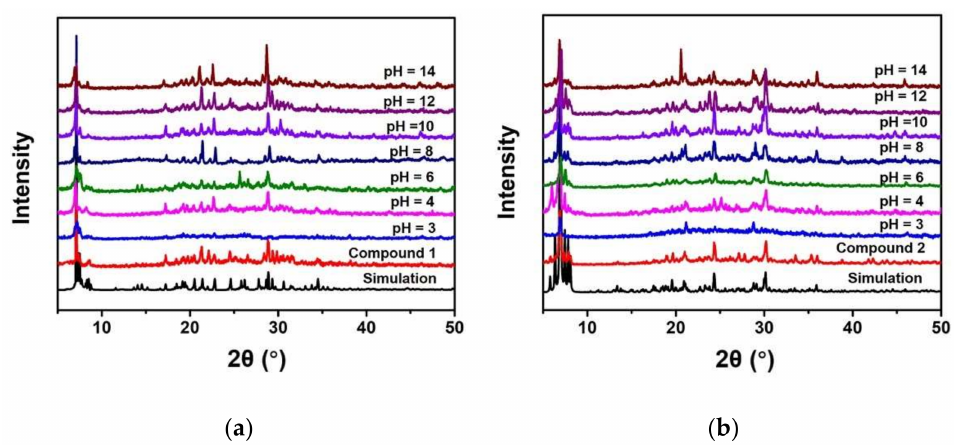
Figure 3. PXRD patterns of 1 ( a ) and 2 ( b ) after being soaked in aqueous solutions with different pH values for 24